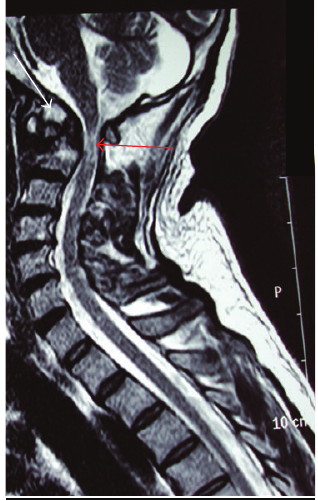
Figure 2: MRI in T2 sequence of the cervical spine. Red arrow: chronic myelopathy (hyperintense signal) can be seen. Anterior to that the bone mass (pseudarthrosis) is seen. The white arrow is indicating the odontoid process of the axis (C2